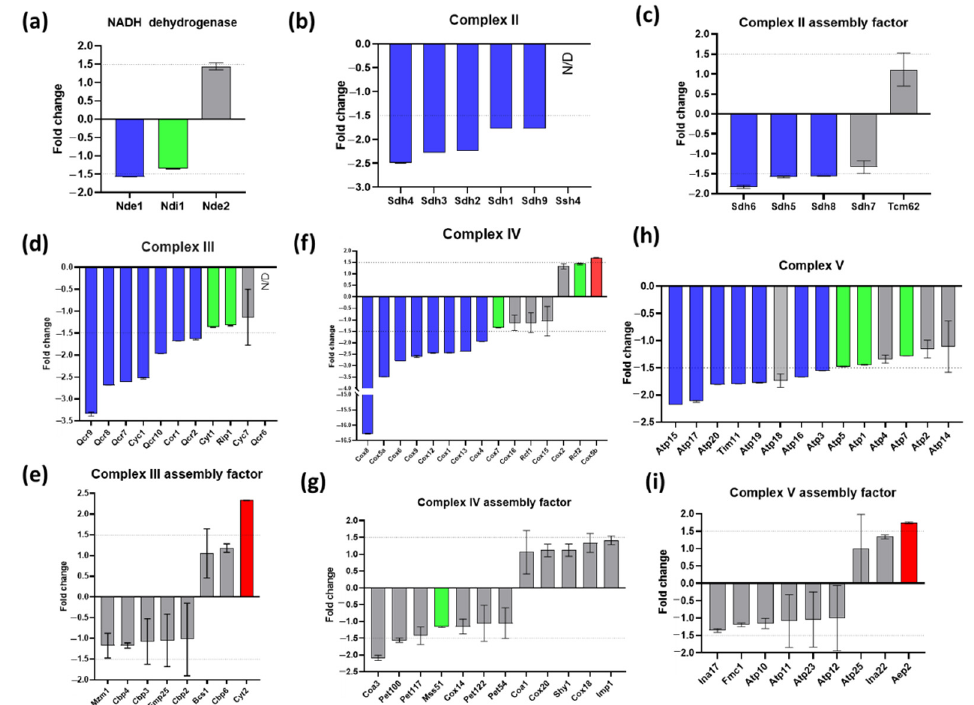
Figure 6. Effect of YME1 deletion on the relative abundance of constitutive components and as- sembly factors of various OXPHOS complexes. ( a ) NADH dehydrogenases; ( b ) complex II com- ponents, ( c ) complex II assemble factors, ( d ) complex III components, ( e ) complex III assemble factors, ( f ) complex IV components, ( g ) complex IV assemble factors, ( h ) complex V components, ( i ) complex V assemble factors. Blue bars represent proteins with significantly decreased abundance; red bars represent proteins with significantly increased abundance; green bars represent signifi- cantly changed proteins (adjusted p < 0.05) but with lower fold change then the cut-off point ( − 1.5 < fold change < 1.5); and grey bars represent non-significant change proteins ( − 1.5 < fold change < 1.5 and/or p > 0.05). N/D: proteins that were not identified in the WT and Δ yme1 samples. Dash lines represent fold change of ±1.5, the cut off for protein abundance change that was considered signif- icantly changed. Error bars represent standard error from MSstats output.